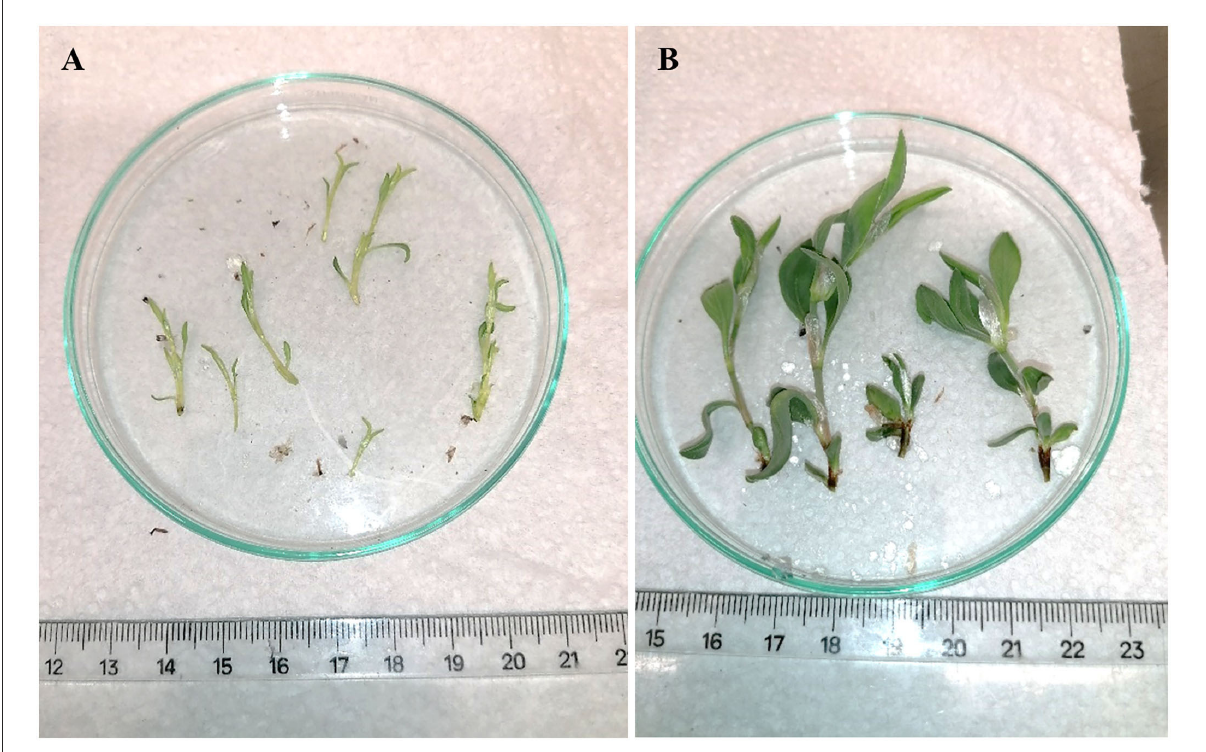
FIGURE4 Details of 60-day-old sea knotgrass shoots cultivated in MS supplemented with 3.0 mg/L BA + 0.1 mg/L IAA (A) and 2.0 mg/L KIN (B)